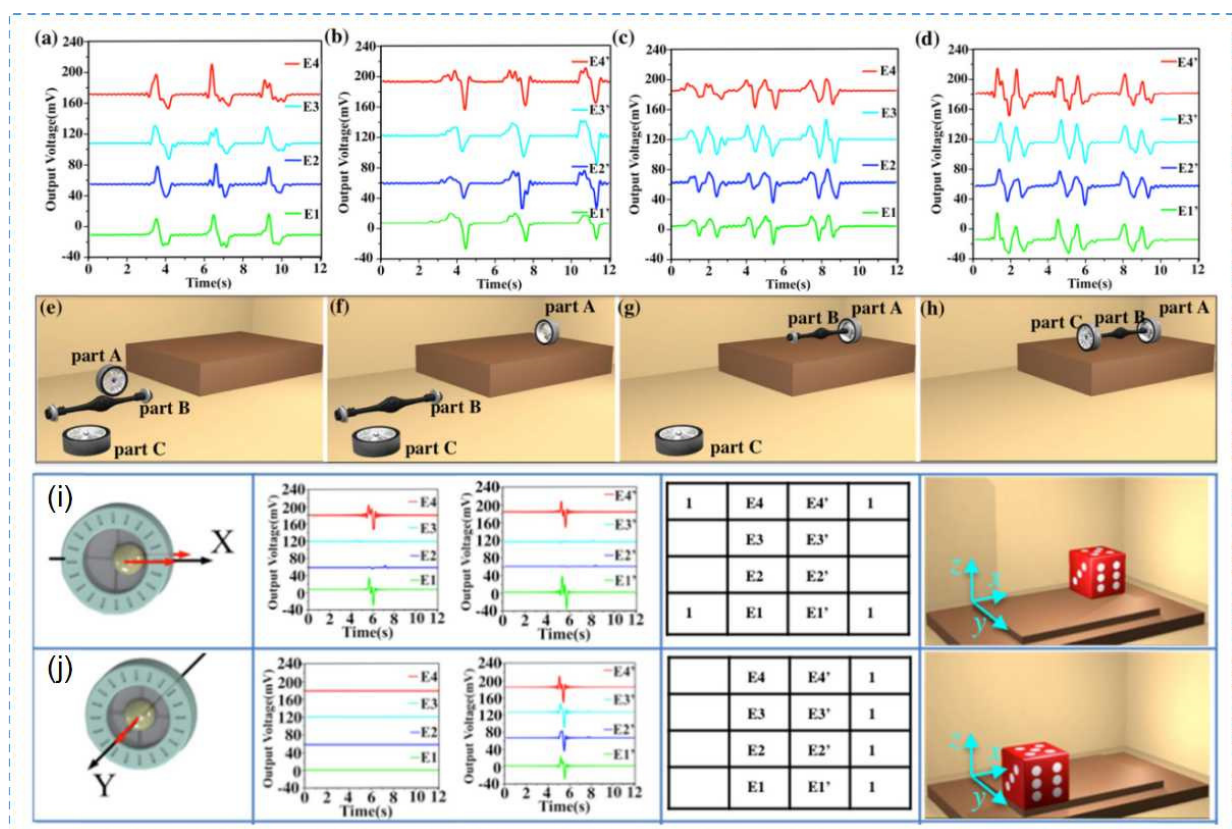
Figure 10. Using 3D self-powered sensor AR interface of virtual assembly, Reprinted with permission from ref. [41]. Copyright 2018 Nano Energy. ( a – h ) part assembly process and corresponding voltage changes; and ( i , j ) relationship between six-axis operation strategy for 3D control sensor and voltage curve with AR interface control dice.